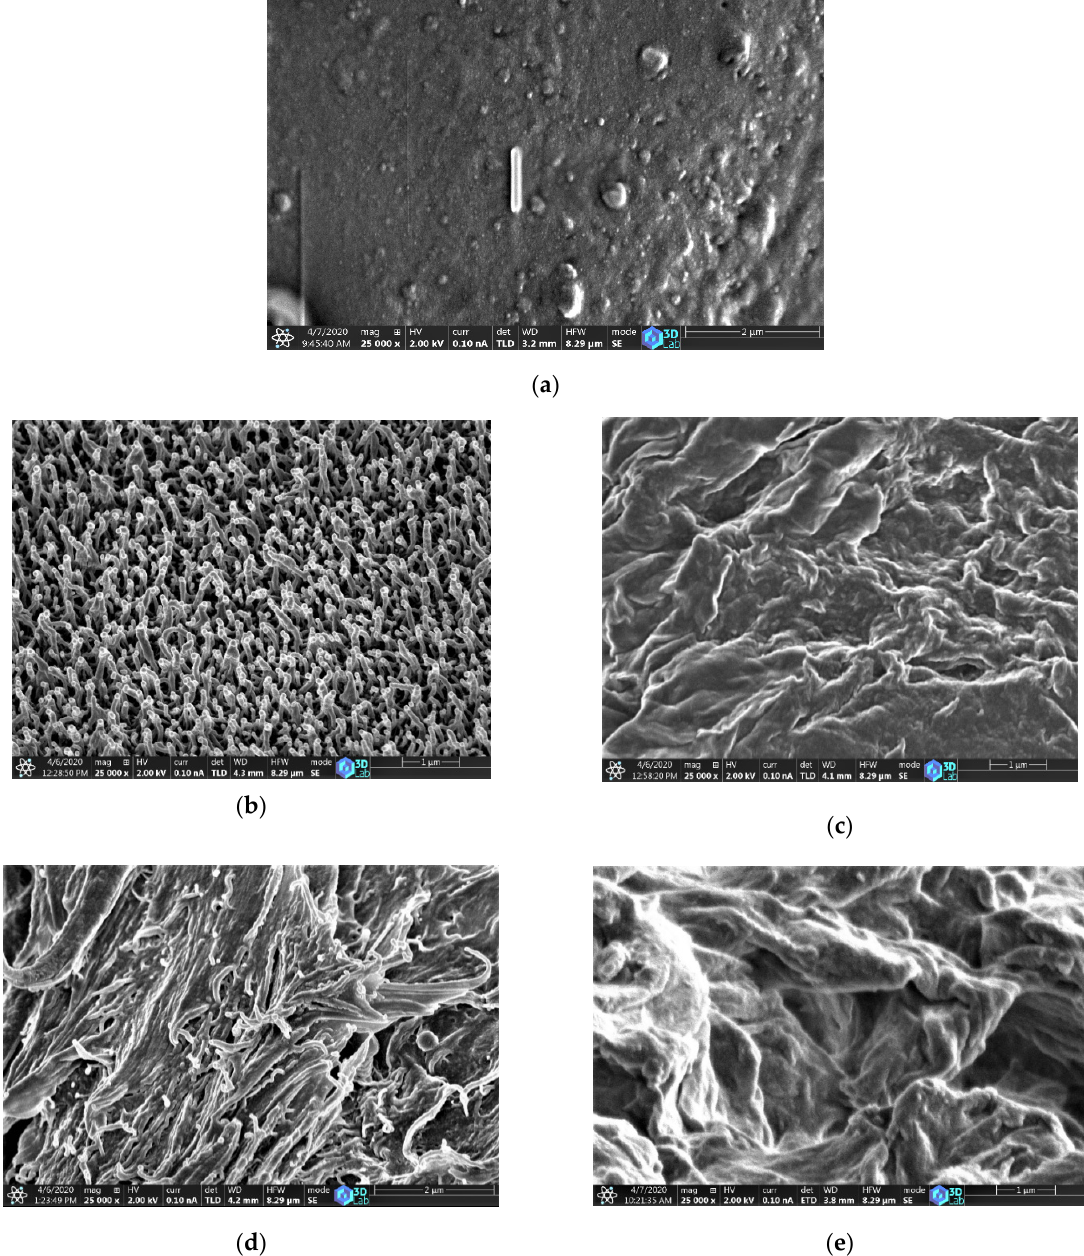
Figure 7. SEM micrograph of raw PLLA ( a ); PLLA crystallized in ethyl acetate at 70 °C for 20 min ( b ); nitrobenzene at 100 °C for 20 min ( c ); ODCB at 100 °C for 5 min ( d ); ODCB at 100 °C for 20 min ( e ).